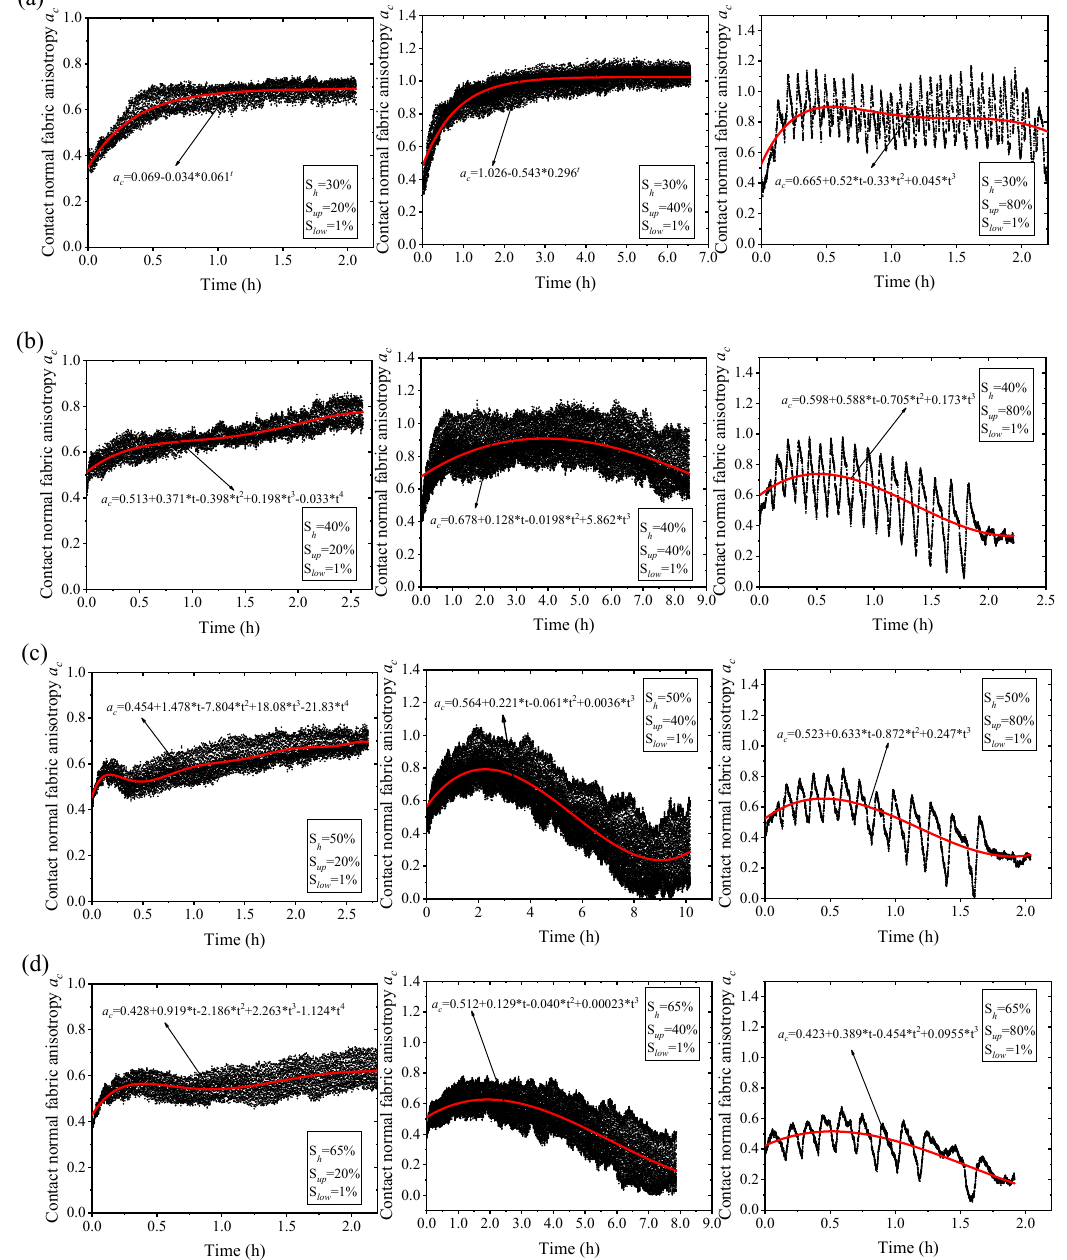
Figure 13. The evolution of contact normal fabric anisotropy under different dynamic amplitude conditions for MHS with different S h values. (a) S h = 30%; (b) S h = 40%; (c) S h = 50%; (d) S h = 65%.